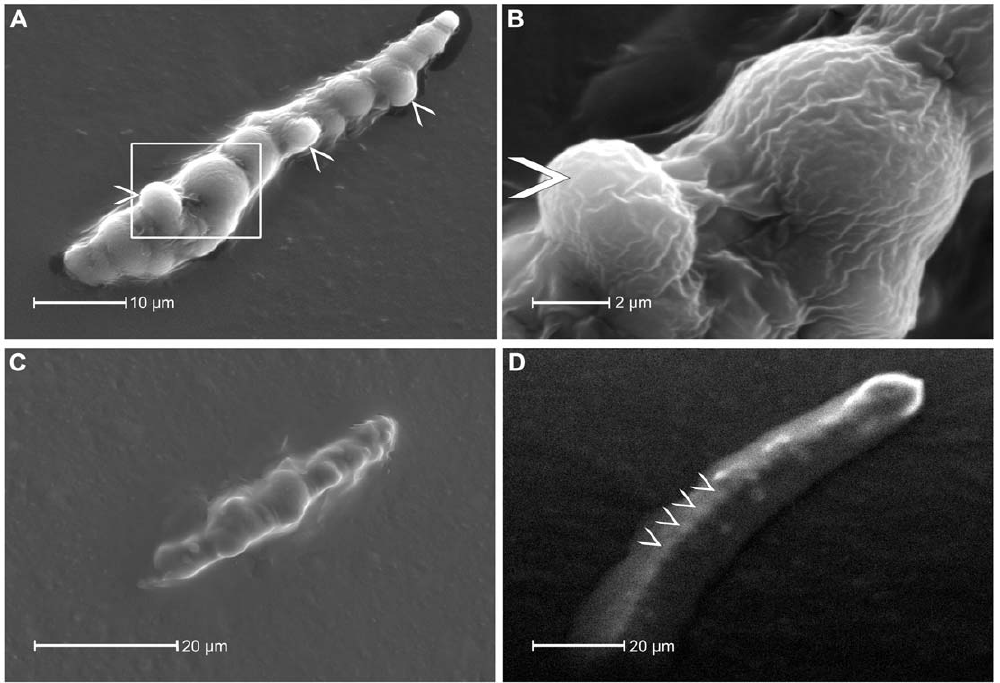
Figure 2. SEM micrographs of salivary sheaths from the aphid M.viciae formed under different oxidizing conditions. Sheaths in each micrograph are entirely attached to the Parafilm membrane that covered the diet; the initial stylet penetration site in Fig. 2A , C and d is located in the lower left corner. A ) A salivary sheath, formed under regular oxygen conditions, shows the typical pearl-necklace structure. The spherical parts of the gel saliva are formed by individual pulses of gel saliva and show clear delimitation from each other. The salivary sheath with a total length of approximately 52 m m tapers towards the tip and shows three short branches (arrowheads) in nearly regular intervals of 12.2; 16.9 and 13.1 m m (mean: 14.07 m m). The area within the white frame is zoomed ( B ) and shows a rough texture of the salivary sheath. A short branch is marked with an arrow head. C ) A gel saliva sheath formed under oxygen-reduced conditions with less clear delimitation of the single saliva drops and a smoother texture than under oxygen conditions. The sheath structure appears to be more flat than under oxygen conditions. D ) Addition of 1 mM DTT to low-oxygen ST-diet leads to a complete loss of the sheath structure. Potential remnants of the pearl-necklet appearance (shown exemplarily by white arrowheads) are visible at regular intervals inside the amorphous